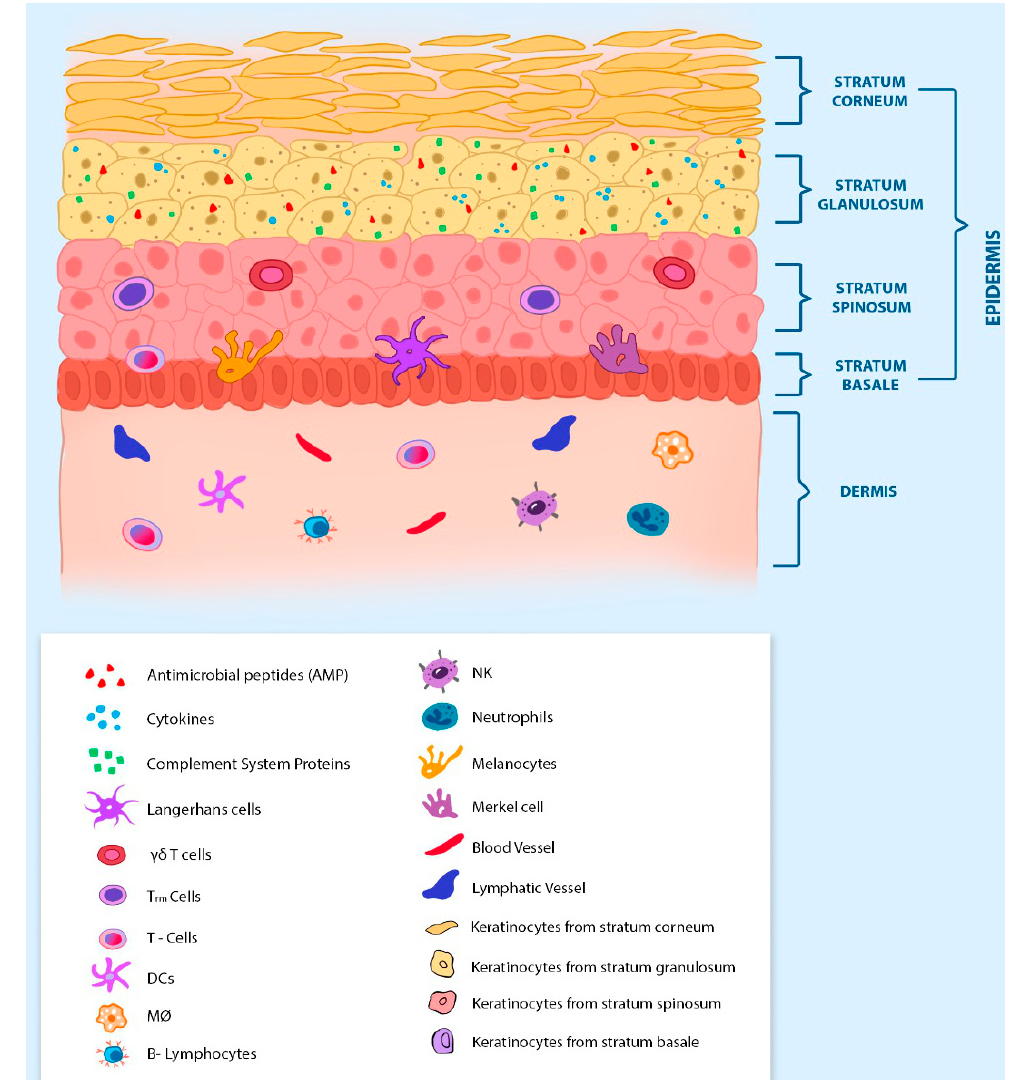
Figure 2. Immune system and histology of the skin: The epidermis and dermis are the two of the most important layers in the skin’s immunity. The epidermis is the outermost layer and is composed of approximately 90% keratinocytes, presenting four specific stratums. The stratum corneum is composed of terminally differentiated keratinocytes, also called corneocytes. The stratum granulosum is composed of granular keratinocytes. This is the first epidermis stratum with components of the immune system, such as cytokines, antimicrobial peptides, and proteins from the complement system. Below the stratum granulosum is the stratum spinous. The keratinocytes of the spinous stratum have cytoplasmic spinous processes that extend to meet the processes of the adjacent cells. This is the first epidermis stratum with immune cells like T-cells, γδ T-cells, and Tissue-resident memory T-cells (TRM cells). Besides the immune cells, the interface between the stratum spinous and stratum basale is composed of melanocytes, Merkel cells, and Langerhans cells. The stratum basale is the innermost layer of the epidermis and it is in close contact with the dermis, which has the greatest variety of immune cells. The dermis has an abundant vascular system, with blood and lymphatic vessels. The most prevalent types of cells in the dermis are T and B cells, DCs, NKs, neutrophils, and macrophages. These two skin layers represent an important physical and biologic barrier to the host. Although most of the studies about CBM disease neglect the skin’s immunity, an understanding of this immune organ is of paramount importance for the control and treatment of the